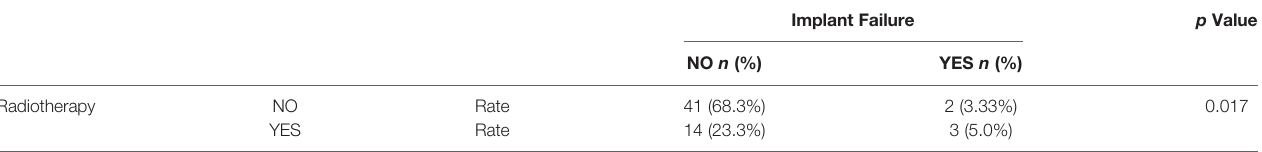
TABLE 4 | Association between radiotherapy and implant